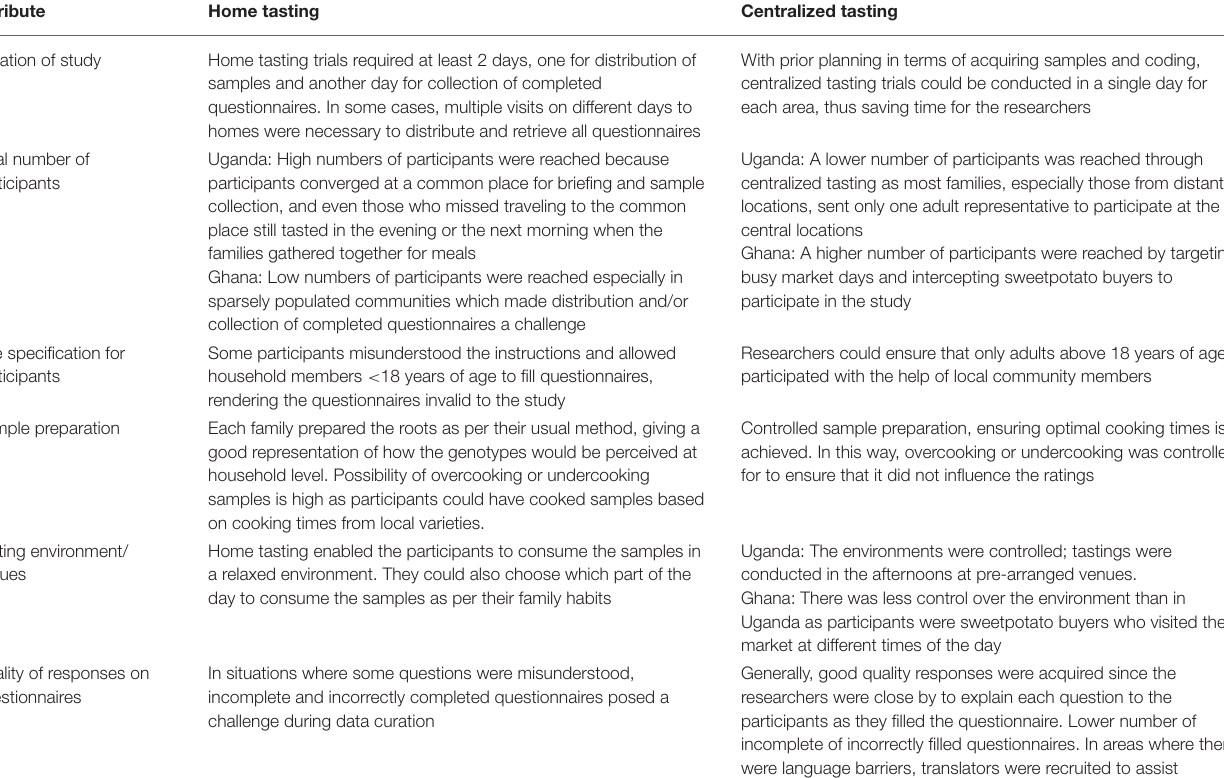
TABLE 8 | Comparison between home and centralized tasting as approaches for consumer preference studies using the tricot method. Attribute Home tasting Centralized tasting Duration of